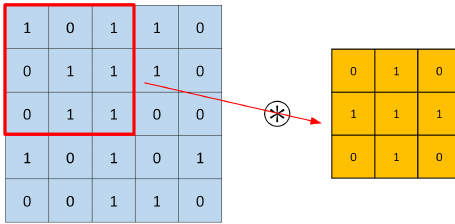
Figure 16. An example of convolutional layer.